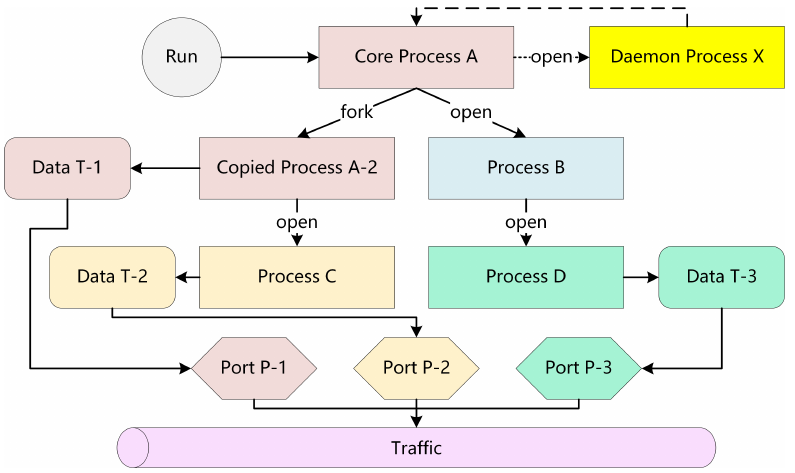
Figure 7. Traffic generation and process tree development in multi-process